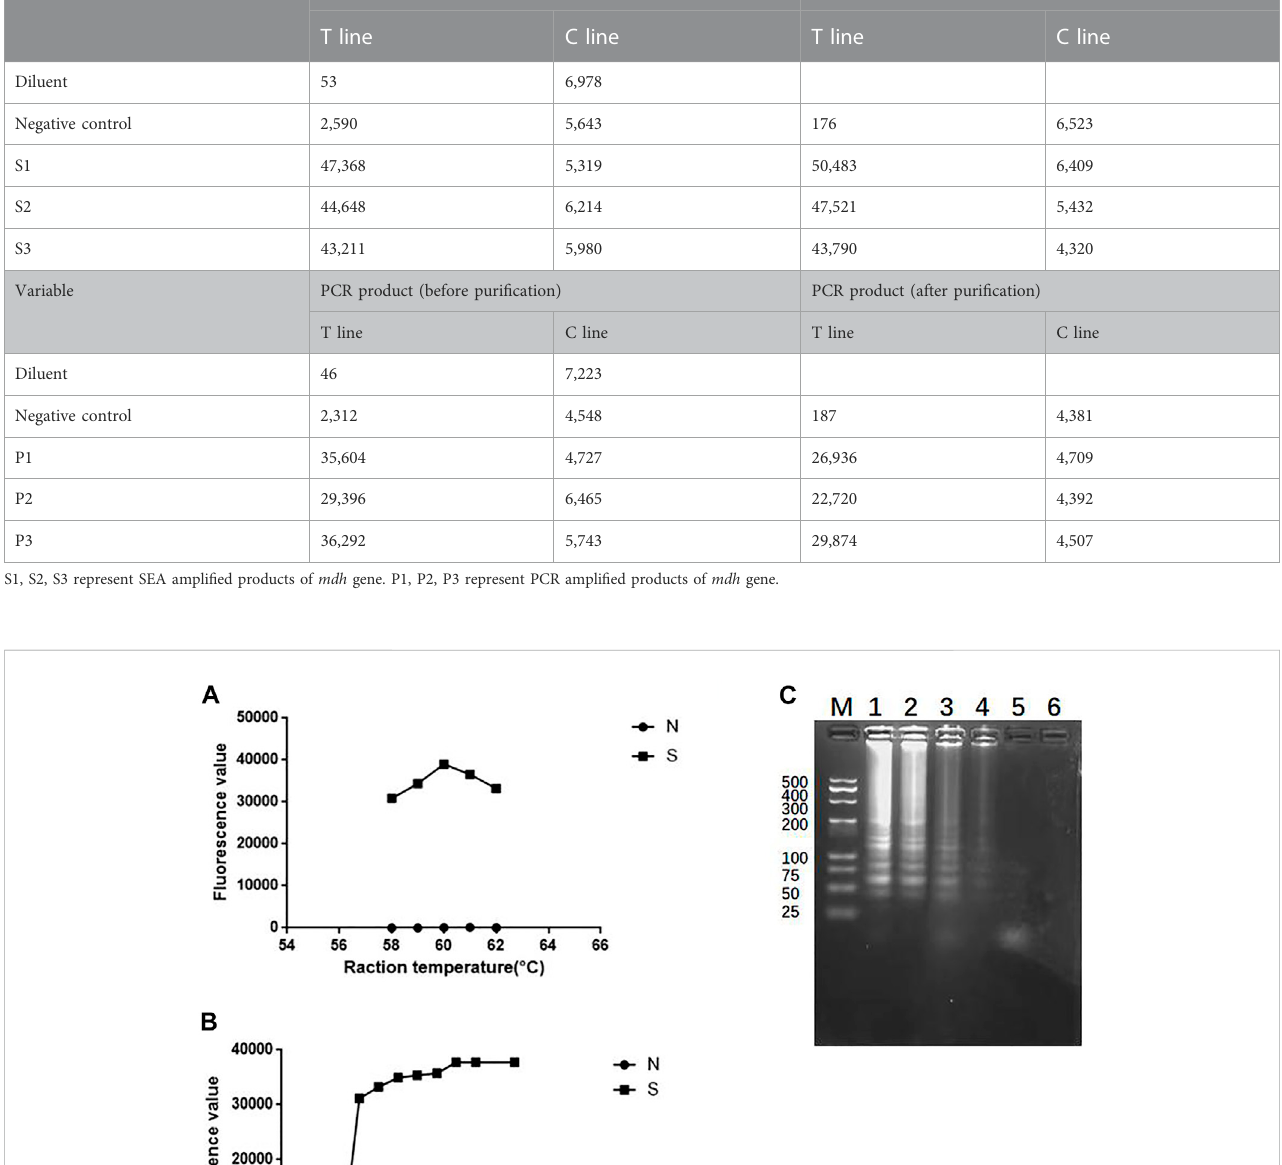
TABLE 2 The fl uorescence intensity results of before and after puri fi cation of SEA/PCR products. Variable